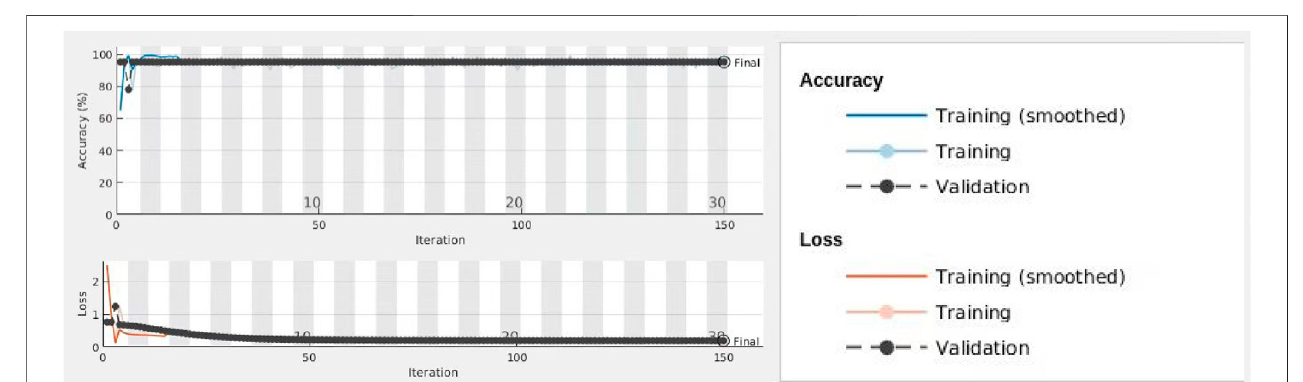
FIGURE 6 | Process of training and validation for chronic cervicitis and cancer